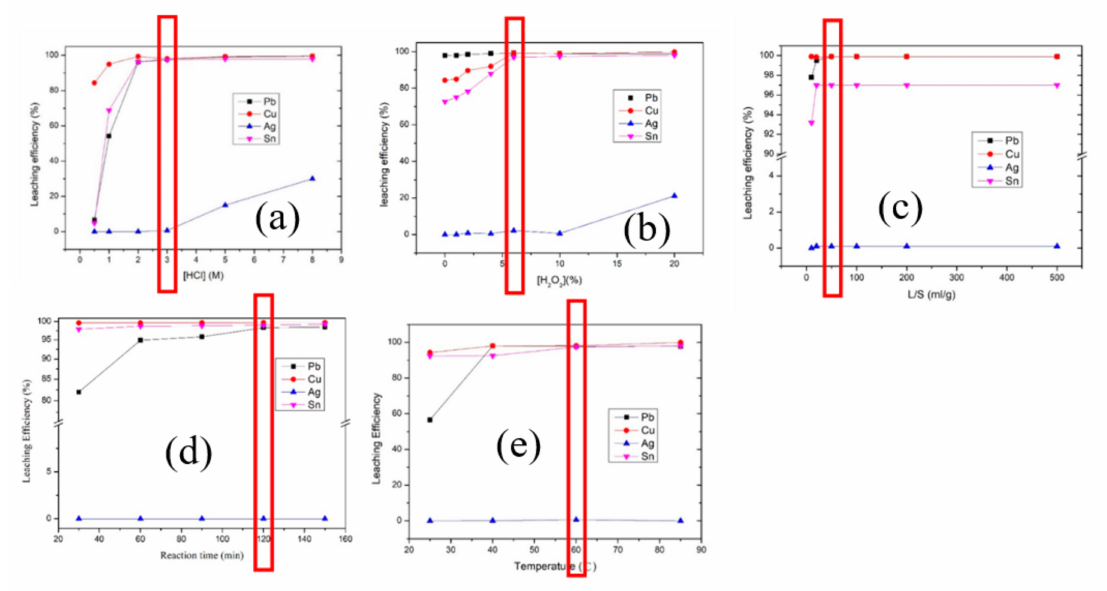
Figure 7. The optimized parameters of PV ribbon leaching treatment: ( a ) Concentration of Hydrochloric acid, ( b ) concentra- tion of H 2 O 2 , ( c ) liquid–solid ratio. ( d ) Reaction time, and ( e ) reaction temperature.